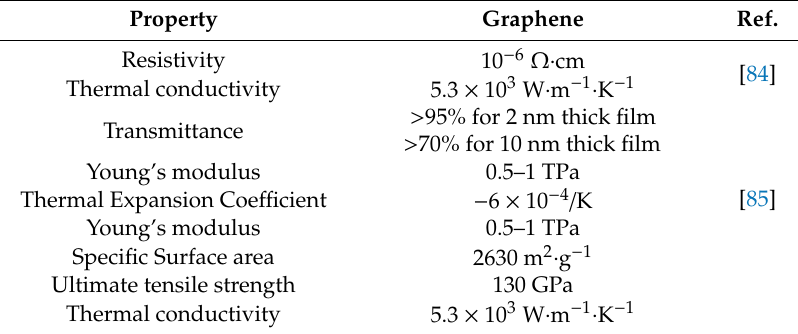
Table 2. The most important mechanical and physical characteristics of